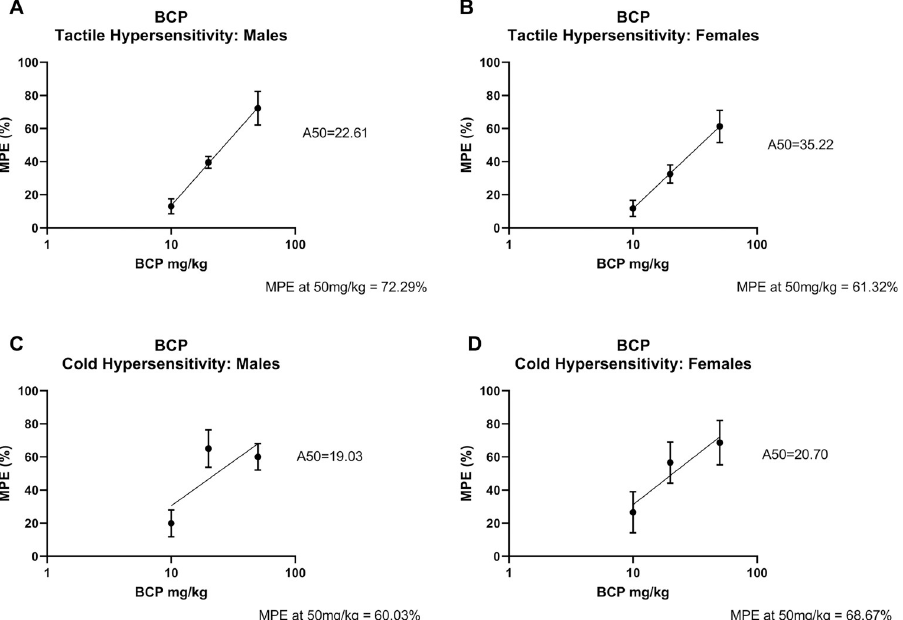
Fig 4. Dose response curves for BCP antinociceptive effects in male and female rats. Dose response curves for the effect of BCP on mechanical paw withdrawal threshold in A) males and B) females and acetone responses in C) males and D) females. A50 for each treatment group is displayed. MPE for the highest dose of BCP is indicated as well. Data are shown as % maximal possible effect (% MPE) ±